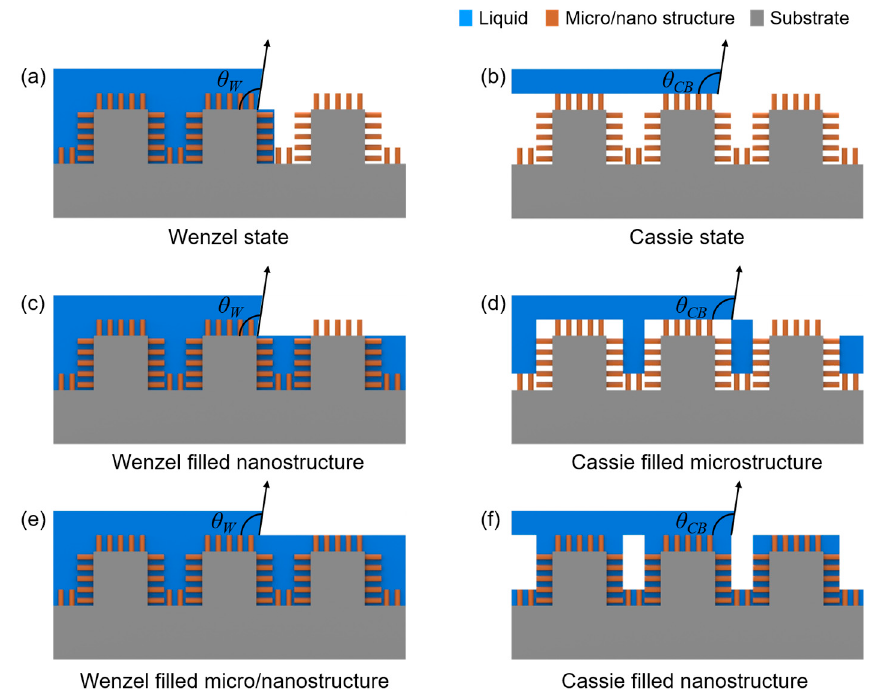
Figure 2. Schematic representation of possible wetting states on a micro/nanoscale rough hierarchical superhydrophobic surface: ( a ) Wenzel state; ( b ) Cassie state; ( c ) Wenzel filled nanostructure; ( d ) Cassie filled microstructure; ( e ) Wenzel filled micro/nanostructure; and ( f ) Cassie filled nanostructure.